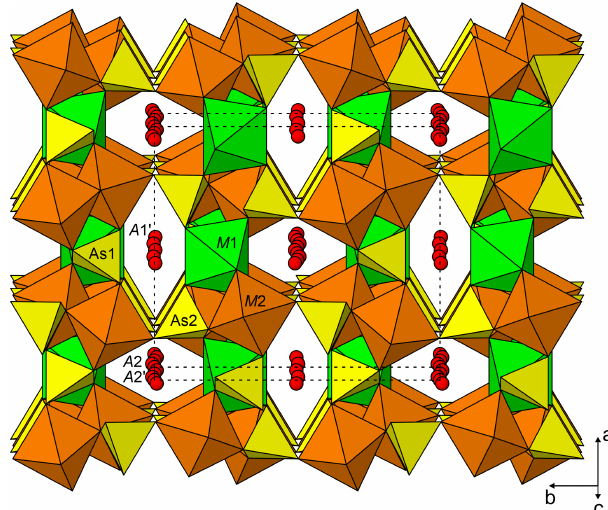
Figure 8. Crystal structure of